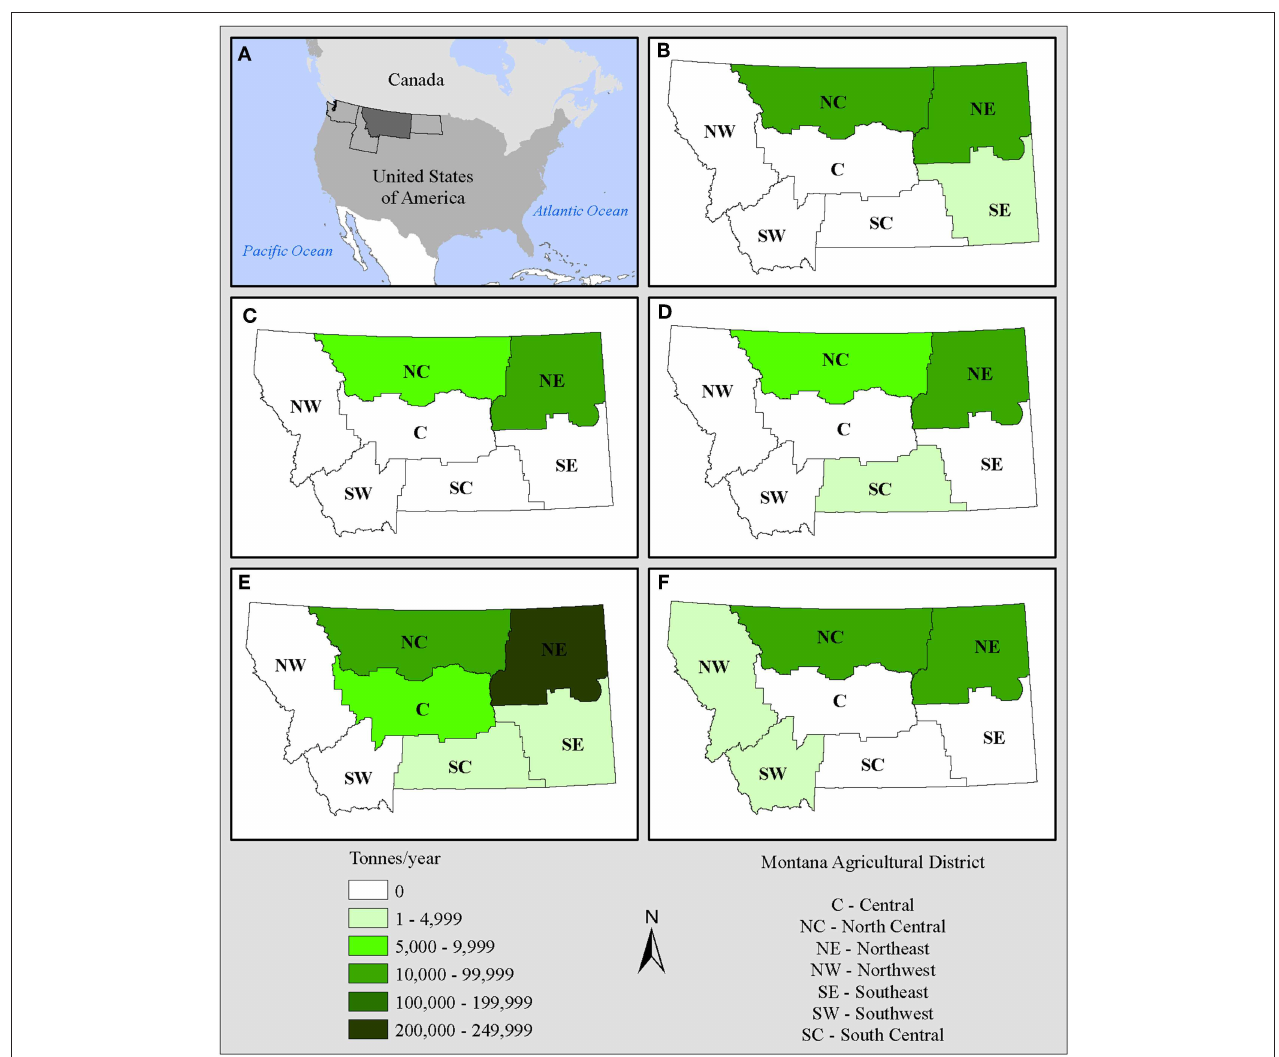
FIGURE 1 | Study region and change in montana lentil production. (A) Study region that includes Montana (USA), Idaho (USA), North Dakota (USA), Washington (USA), and Canada; and change in lentil production over time including (B) 2013 Montana lentil production (total tonnes per year) by agriculture district, (C) 2014 Montana lentil production (total tonnes per year) by agriculture district, (D) 2015 Montana lentil production (total tonnes per year) by agriculture district, (E) 2016 Montana lentil production (total tonnes per year) by agriculture district, (F) 2017 Montana lentil production (total tonnes per year) by agriculture district. Data source: Shapefiles from Montana State Library Geographic Information Clearinghouse and United States Geological Survey; lentil production from United States Department of Agriculture National Agricultural Statistics Service, accessed March,